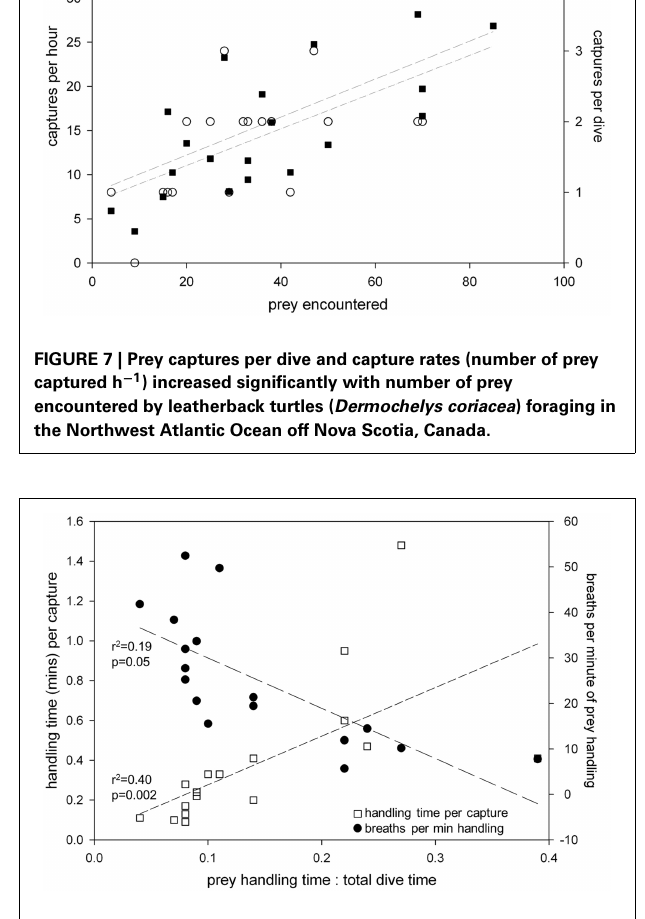
FIGURE 8 | Handling time (min) per capture increased while breaths per minute of prey handling decreased with increasing proportion of prey handling time relative to total dive time in leatherback turtles ( Dermochelys coriacea ) foraging in the Northwest Atlantic Ocean off Nova Scotia,